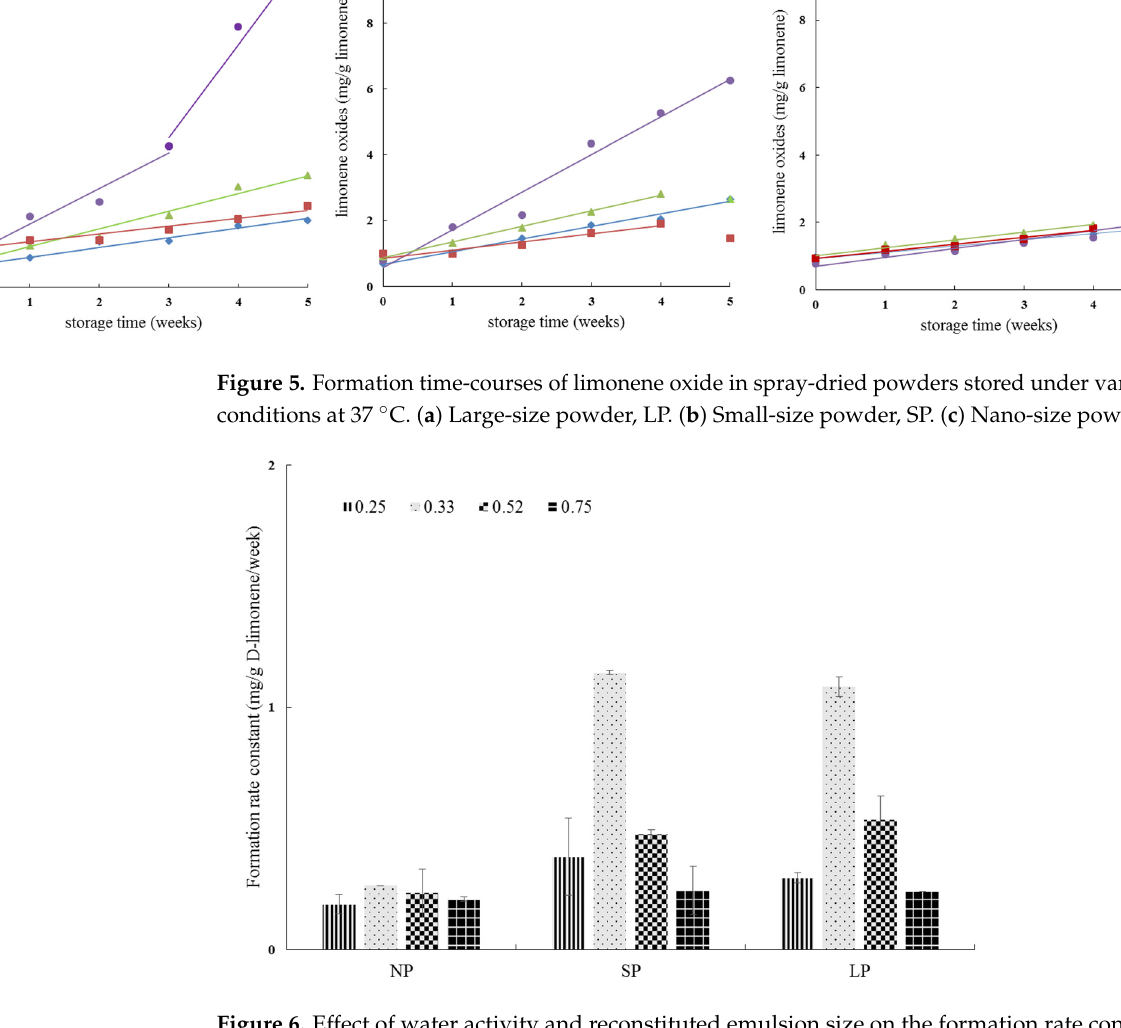
Figure 6. Effect of water activity and reconstituted emulsion size on the formation rate constant of limonene oxide in the spray-dried powders stored at 37 °C.